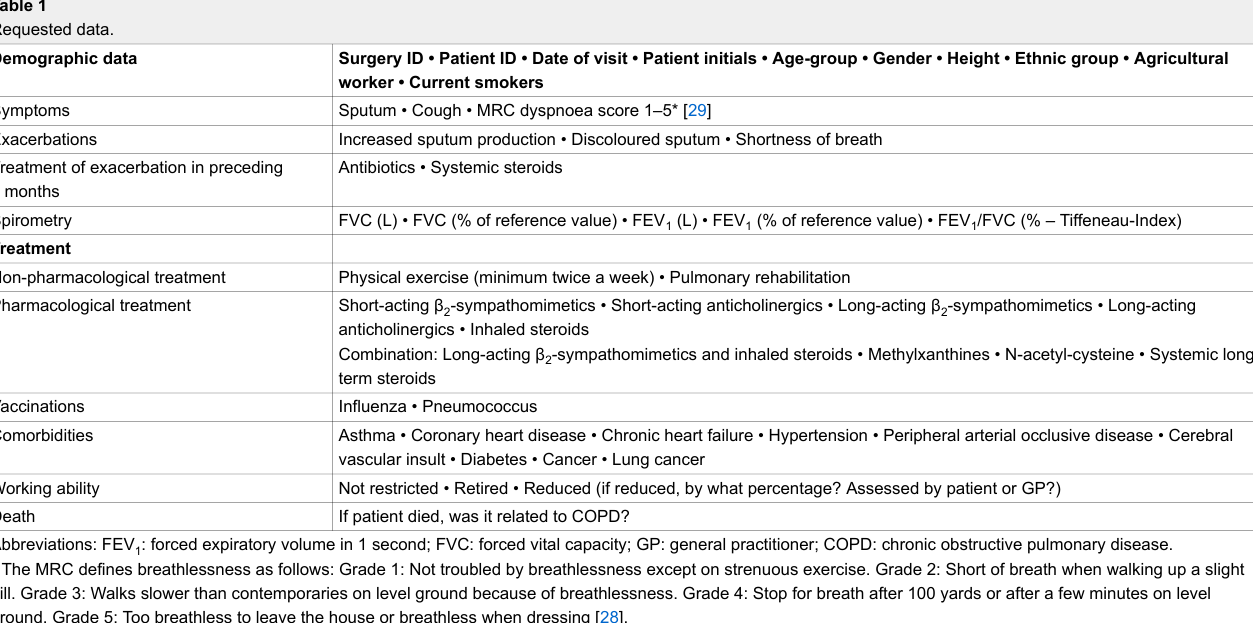
Table 1 Requested